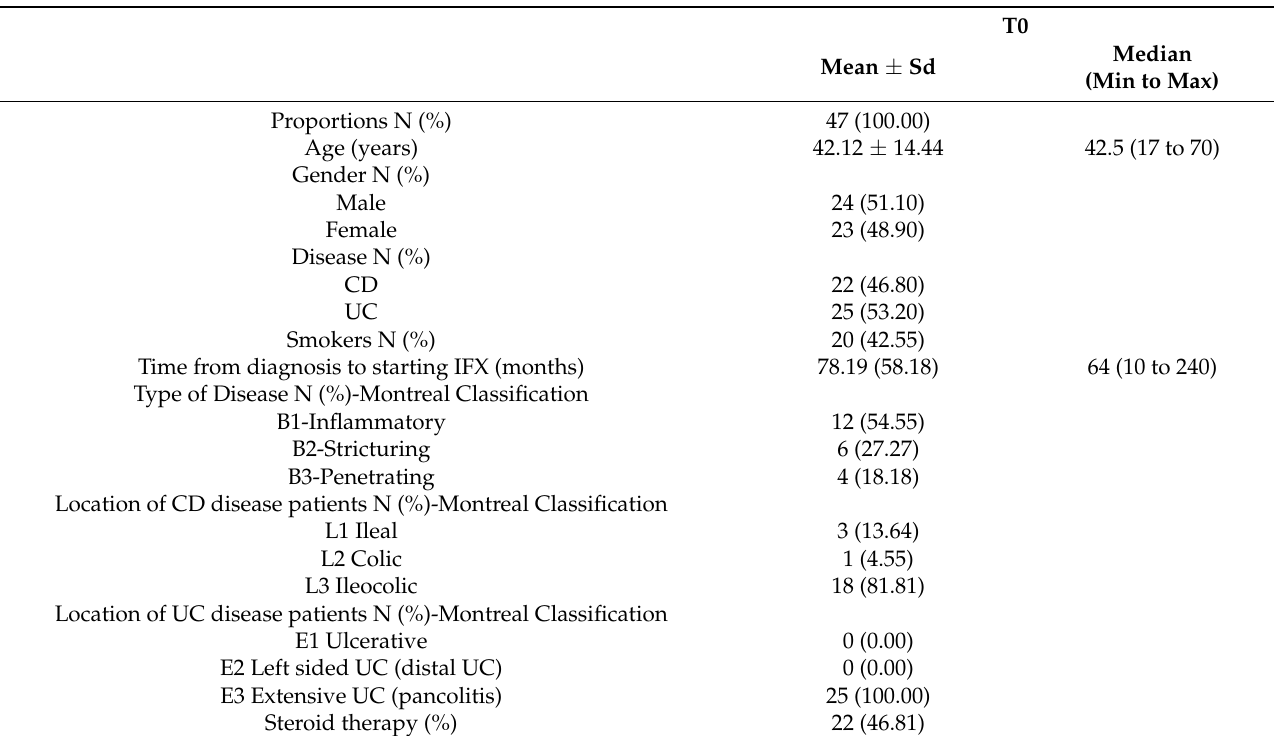
Table 1. Clinicopathologic features of enrolled patients (N: